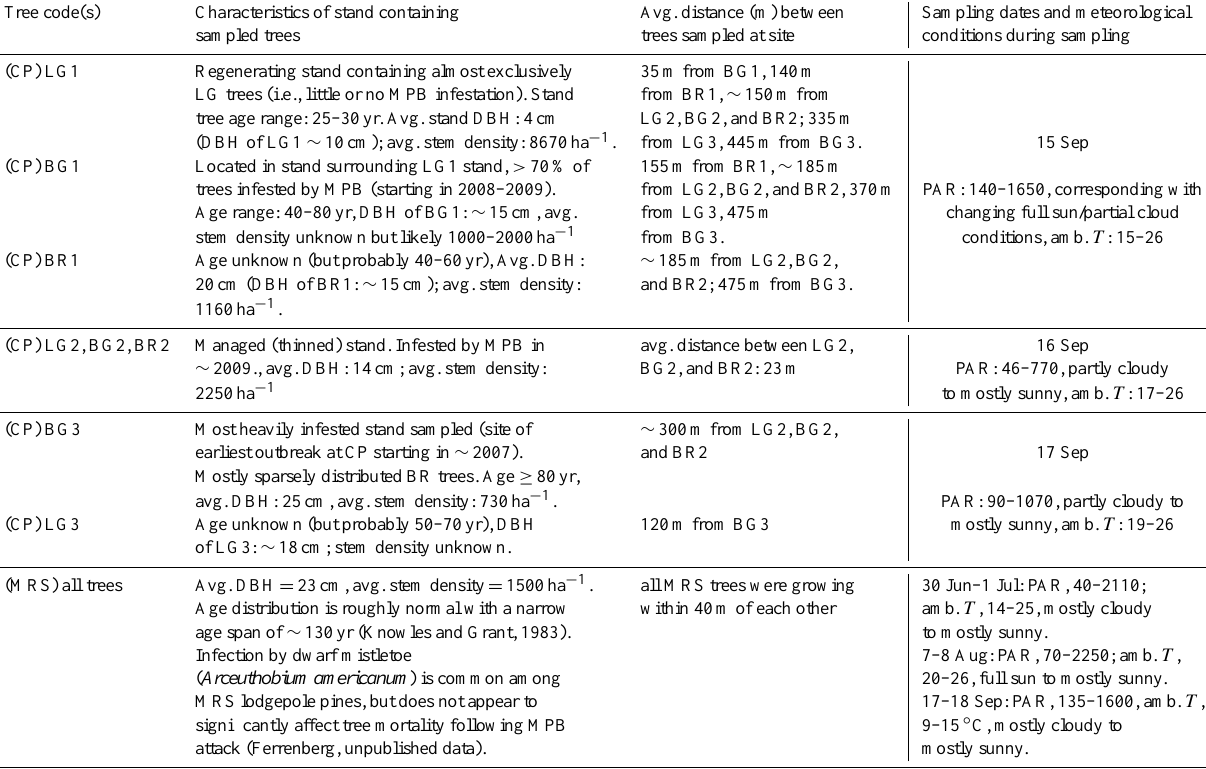
Table 2. Stand characteristics for trees sampled at CP (September 2010) and MRS (June–September 2011) and meteorological conditions during sampling. PAR is expressed in units of µmols − 1 m − 2 ; ambient temperatures (amb. T ) are expressed as ◦ C. Tree code(s) Avg. distance (m) between trees sampled at